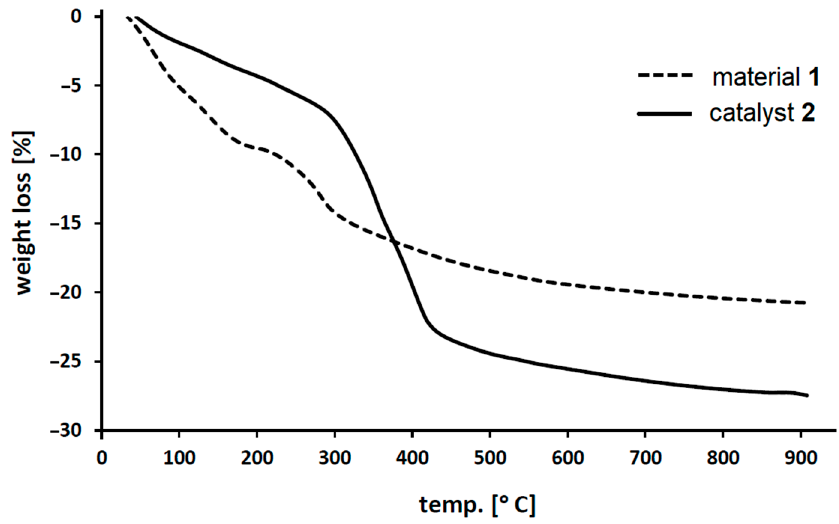
Figure 3. TGA of material 1 and catalyst 2 .